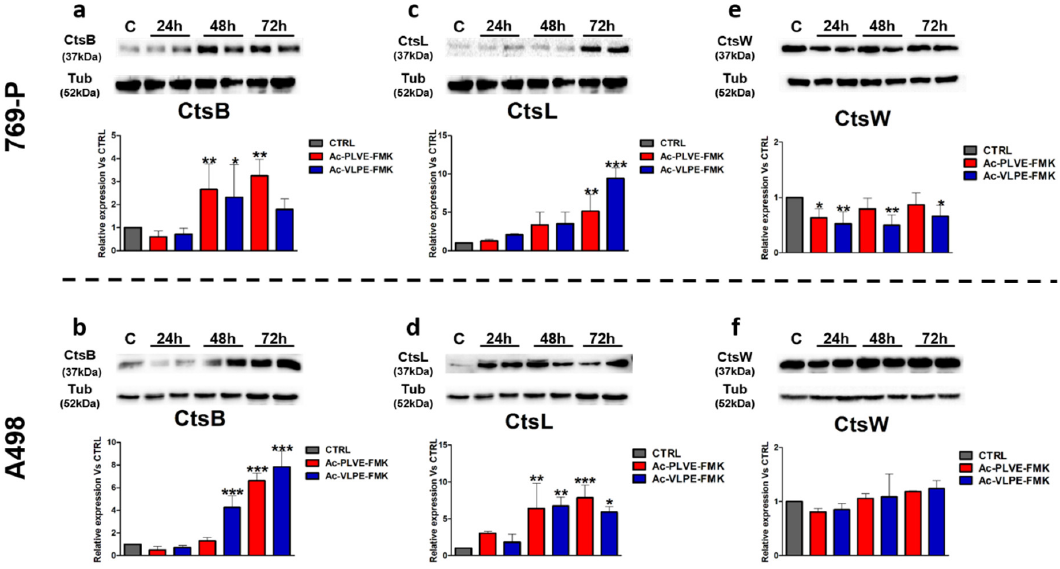
Figure 8. Effect of the peptides on CtsB, L, and W expression: ( a ) protein expression of CtsB in 769-P and ( b ) A498 cells after 24, 48, and 72 h of treatment with Ac-PLVE-FMK and Ac-VLPE-FMK. ( c ) protein expression of CtsL in 769-P and ( d ) A498 cells after 24, 48, and 72 h of treatment with Ac-PLVE-FMK and Ac-VLPE-FMK. ( e ) Protein expression of CtsB in 769-P and ( f ) A498 cells after 24, 48, and 72 h of treatment with Ac-PLVE-FMK and Ac-VLPE-FMK. Data are represented as mean ± S.D. of at least three replicates. Significance was calculated through one-way ANOVA followed by Dunnet’s test.